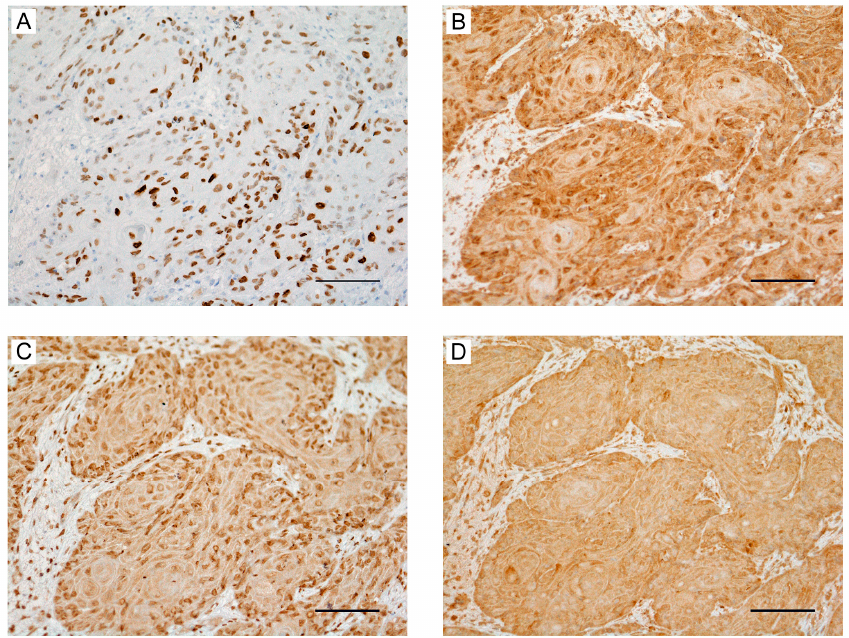
Figure 5. HMGA2 and angiogenesis-related genes are highly co-expressed at sites of lung metastasis. Images of immunohistochemical staining using the following antibodies in lung metastasis specimens: ( A ) HMGA2, ( B ) VEGF-A, ( C ) VEGF-C, and ( D ) FGF-2. Representative microscopic images are shown according to the expression status. Scale bar, 100 μ m.